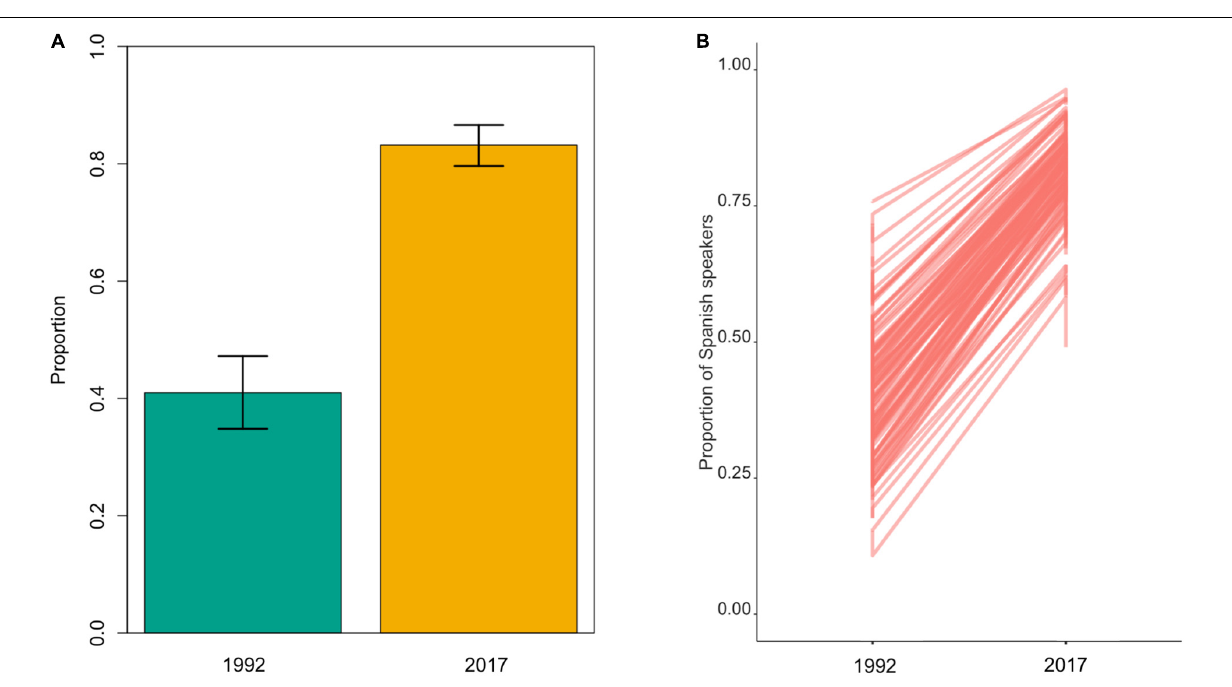
FIGURE 2 | On the left (A) , posterior means (bars) and 90% highest posterior density intervals (HPDIs; error bars) from the Bayesian generalized linear mixed models (GLMMs) predict the average proportion of Spanish speakers in the village setting sigma household to 0. Setting the SDs for the varying intercepts (sigma household) to 0 produces predictions for an average household but ignores uncertainty arising from variation among households. On the right (B) , the results from the simulation of 100 households with unique intercepts sampled from the posterior distribution. This produces predictions that account for a variation among